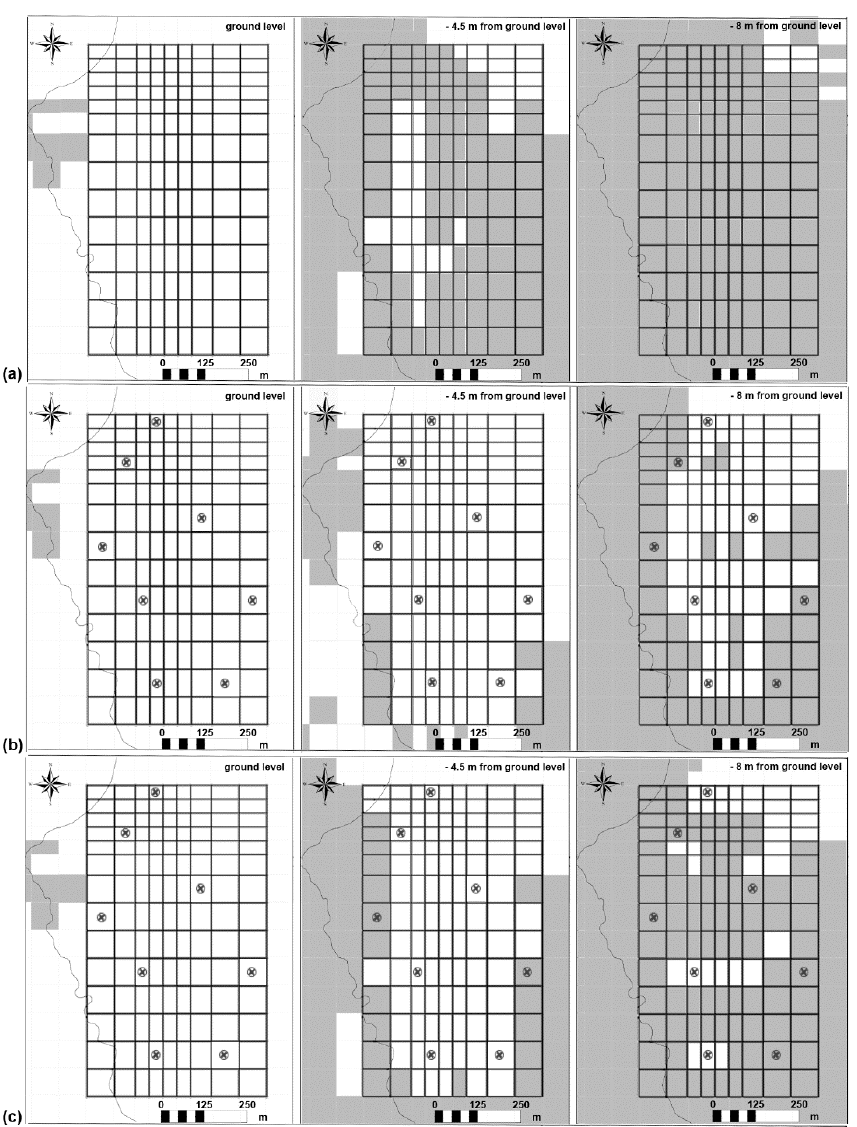
Figure 14. Results of Scenarios 1 ( a ), 2 ( b ), and 3 ( c ); wells (circles) and flooded zones (grey cells) at different depths.